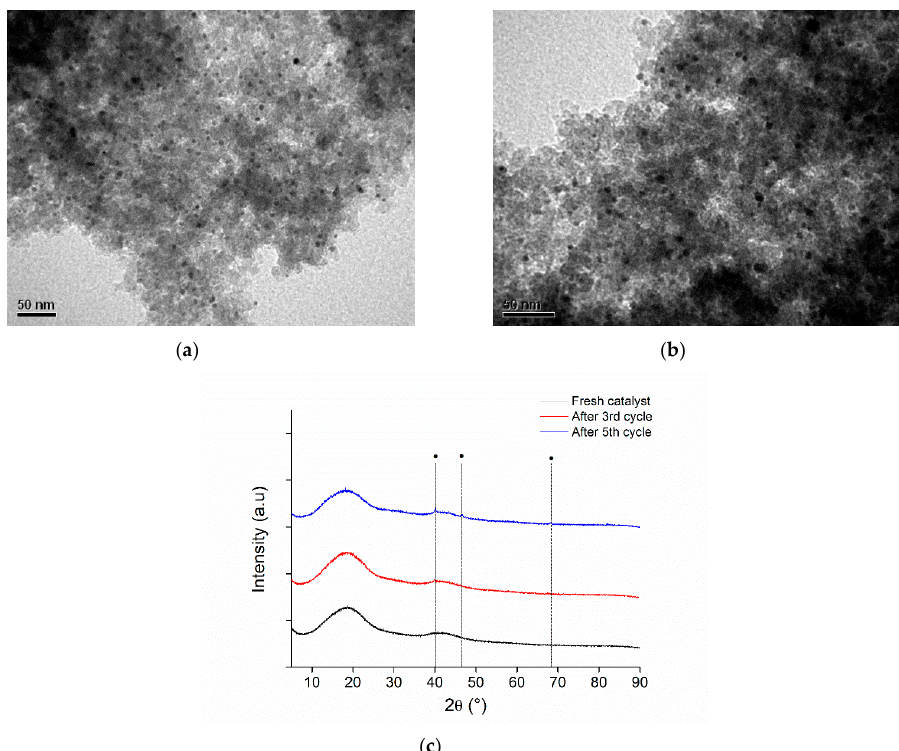
Figure 10. Physicochemical characterization of PdAS(10)-MA used catalyst. ( a ) TEM micrographs for PdAS(10)-MA catalyst after third reaction cycle, ( b ) TEM micrographs for PdAS(10)-MA catalyst after fifth reaction cycle, and ( c ) XRD diffraction pattern for the fresh catalyst, after third and fifth reaction cycle ( ● Metallic Pd (JCPDS 65-2867)).